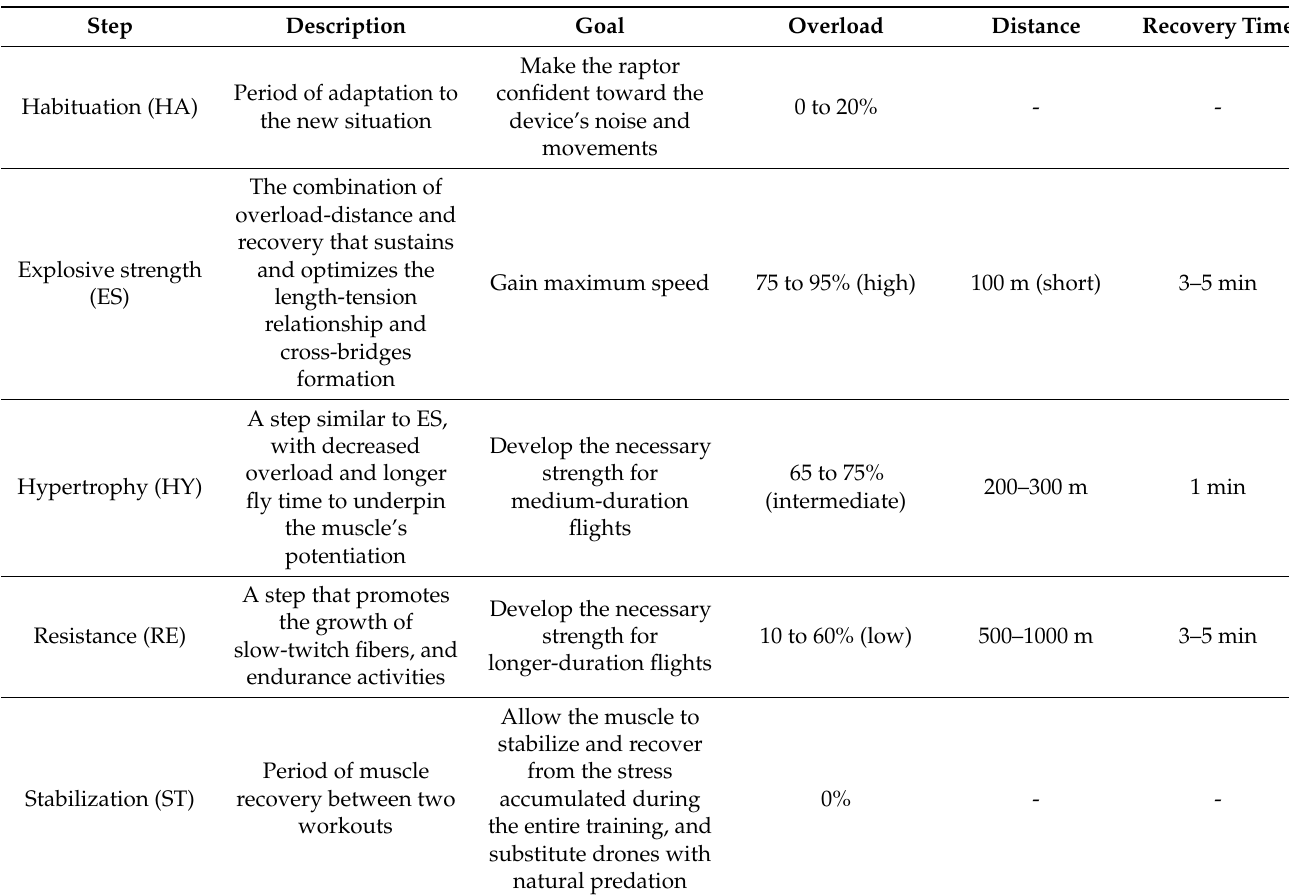
Table 2. Training phases for specific purposes. Workout sequence. Each raptor received a tailored exercise regimen, which could consist of two or more phases (HA being a common step for all of